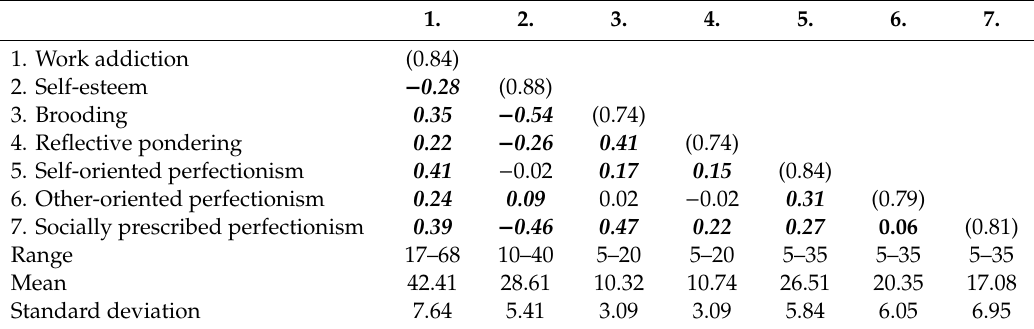
Table 1. Means, standard deviations, reliabilities, and inter-correlations of self-esteem, self-oriented perfectionism, other-oriented perfectionism, brooding, reflective pondering, and work